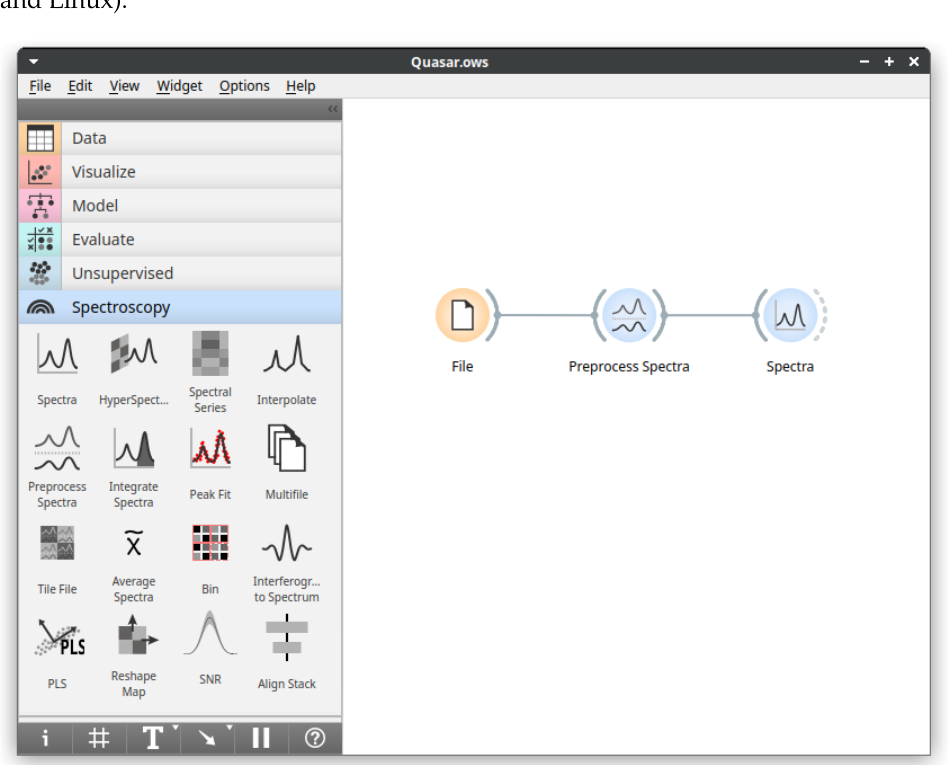
Figure 1. The main Quasar window. The left part of the window contains available analysis components (widgets) organized into categories with the Spectroscopy category open. The right part of the widow is the workflow editor; the displayed workflow performs basic data